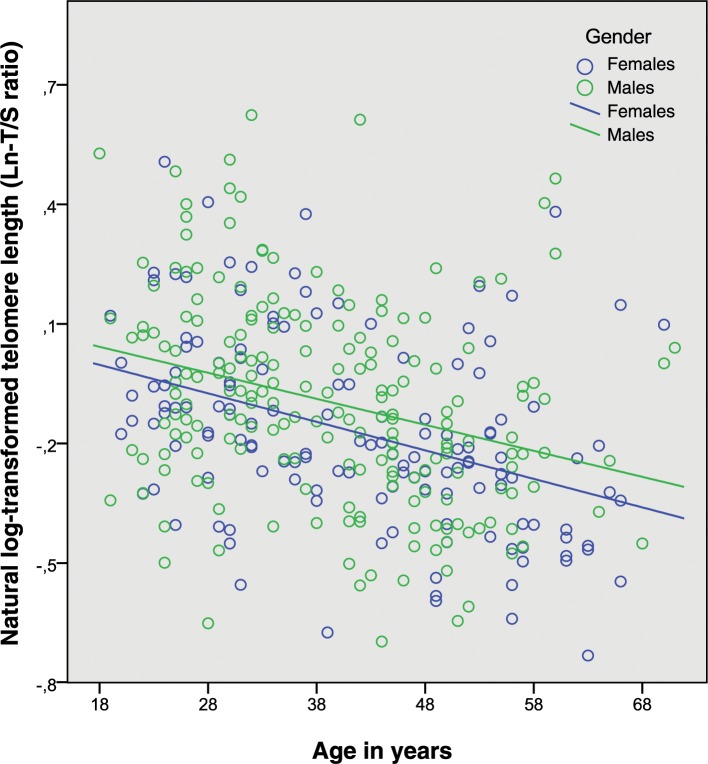
Age and natural log-transformed telomere length, males and females, n = 343.The association of TL with age, visualized by the regression lines for men (blue circles) and women (green circles), respectively.